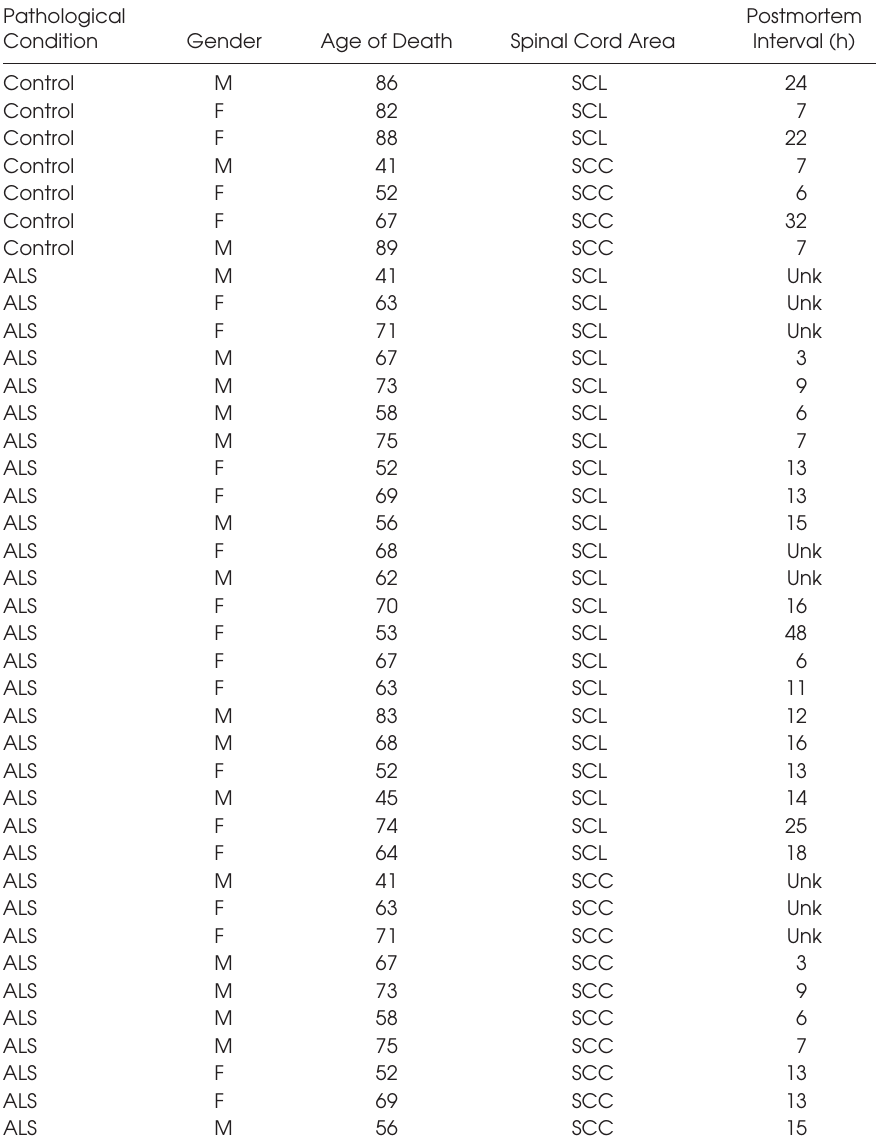
table 2. Spinal cord tissue analyzed in this study. Pathological